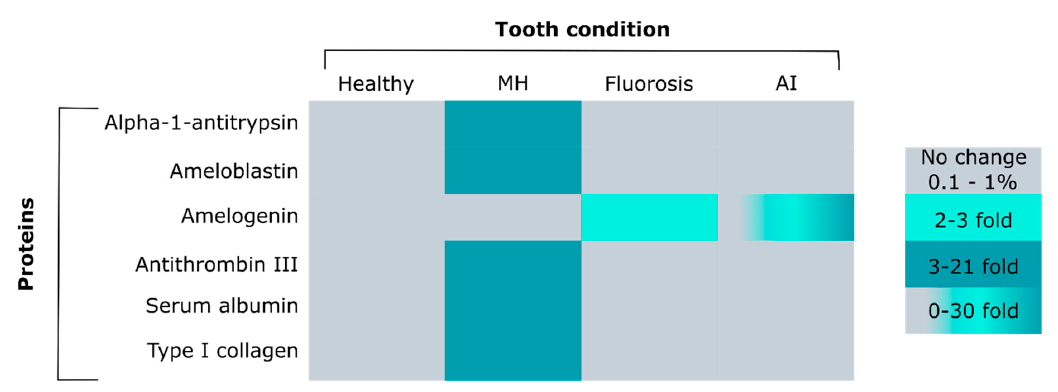
Figure 3. Comparison of protein content between healthy and diseased tooth enamel. Shown proteins are seen in (rows) identified in any of the tooth conditions (columns) are illustrated. Healthy teeth shown as reference in light grey, Chalky/ Molar Hypomolarization (MH): enamel affected by molar hypomineralization [48,50,92], Fluorosis [93–95] and Amelogenesis Imperfecta (AI): hypocalcified and hypomaturation amelogenesis imperfecta enamel [88–90]; Range of percent by weight (wt%) of protein abundance relative to healthy enamel show in colors: light gray for healthy range of 0.1 -1